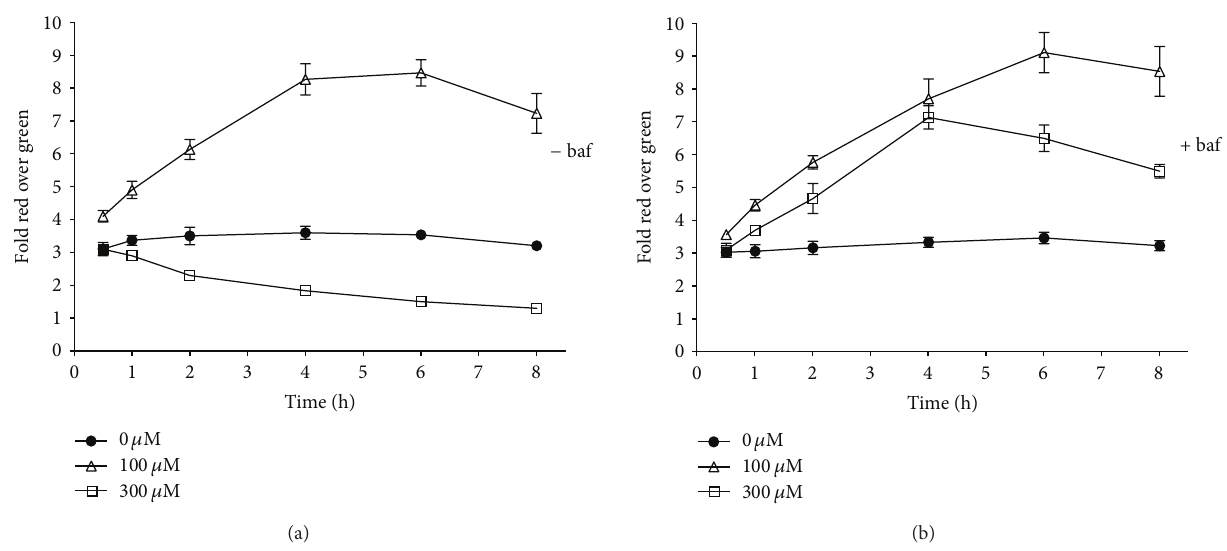
Figure 6: Baf (30nM) cotreatment shifted the mitochondrial polarization state of rat hepatocytes treated with NMTMB over an 8-hour time course. Rat hepatocytes were treated with NMTMB for 30 minutes, 1h, 2 h, 4h, 6h or 8h. Mitochondrial polarization status was monitored using JC-1fluorescence on a Molecular Devices Flexstation instrument. Thedata are expressed as an average of 3 replicates ( ± SD) from a single cell isolate. Statistically significant differences between control replicates and that for all NMTMB conditions was achieved by 1h ( 𝑃 < 0.05 , 𝑡